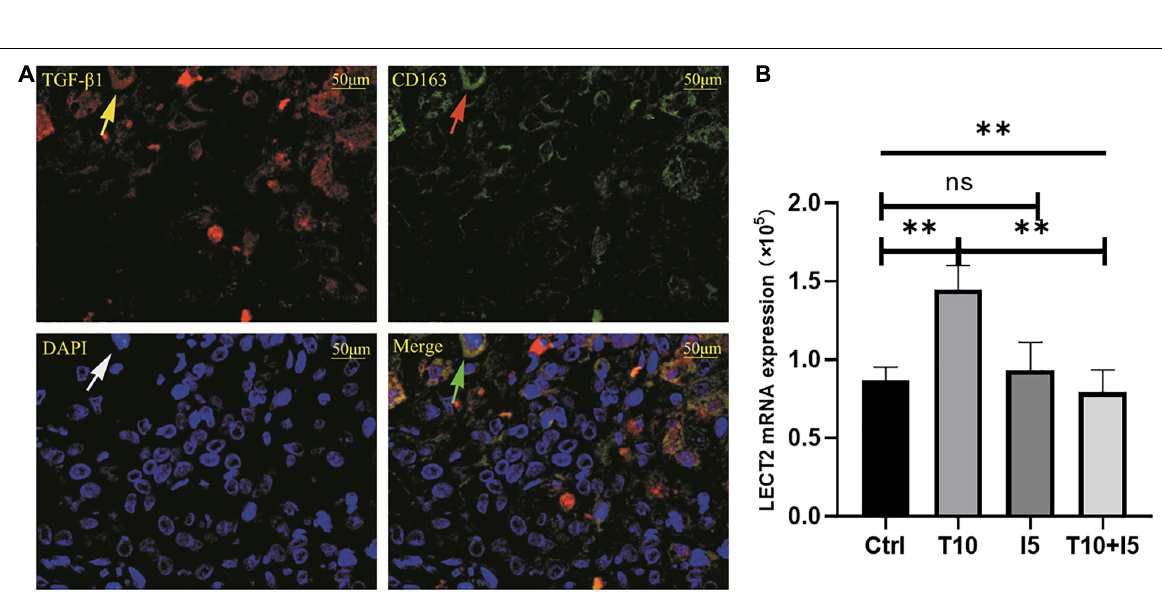
Frontiers in Pediatrics |